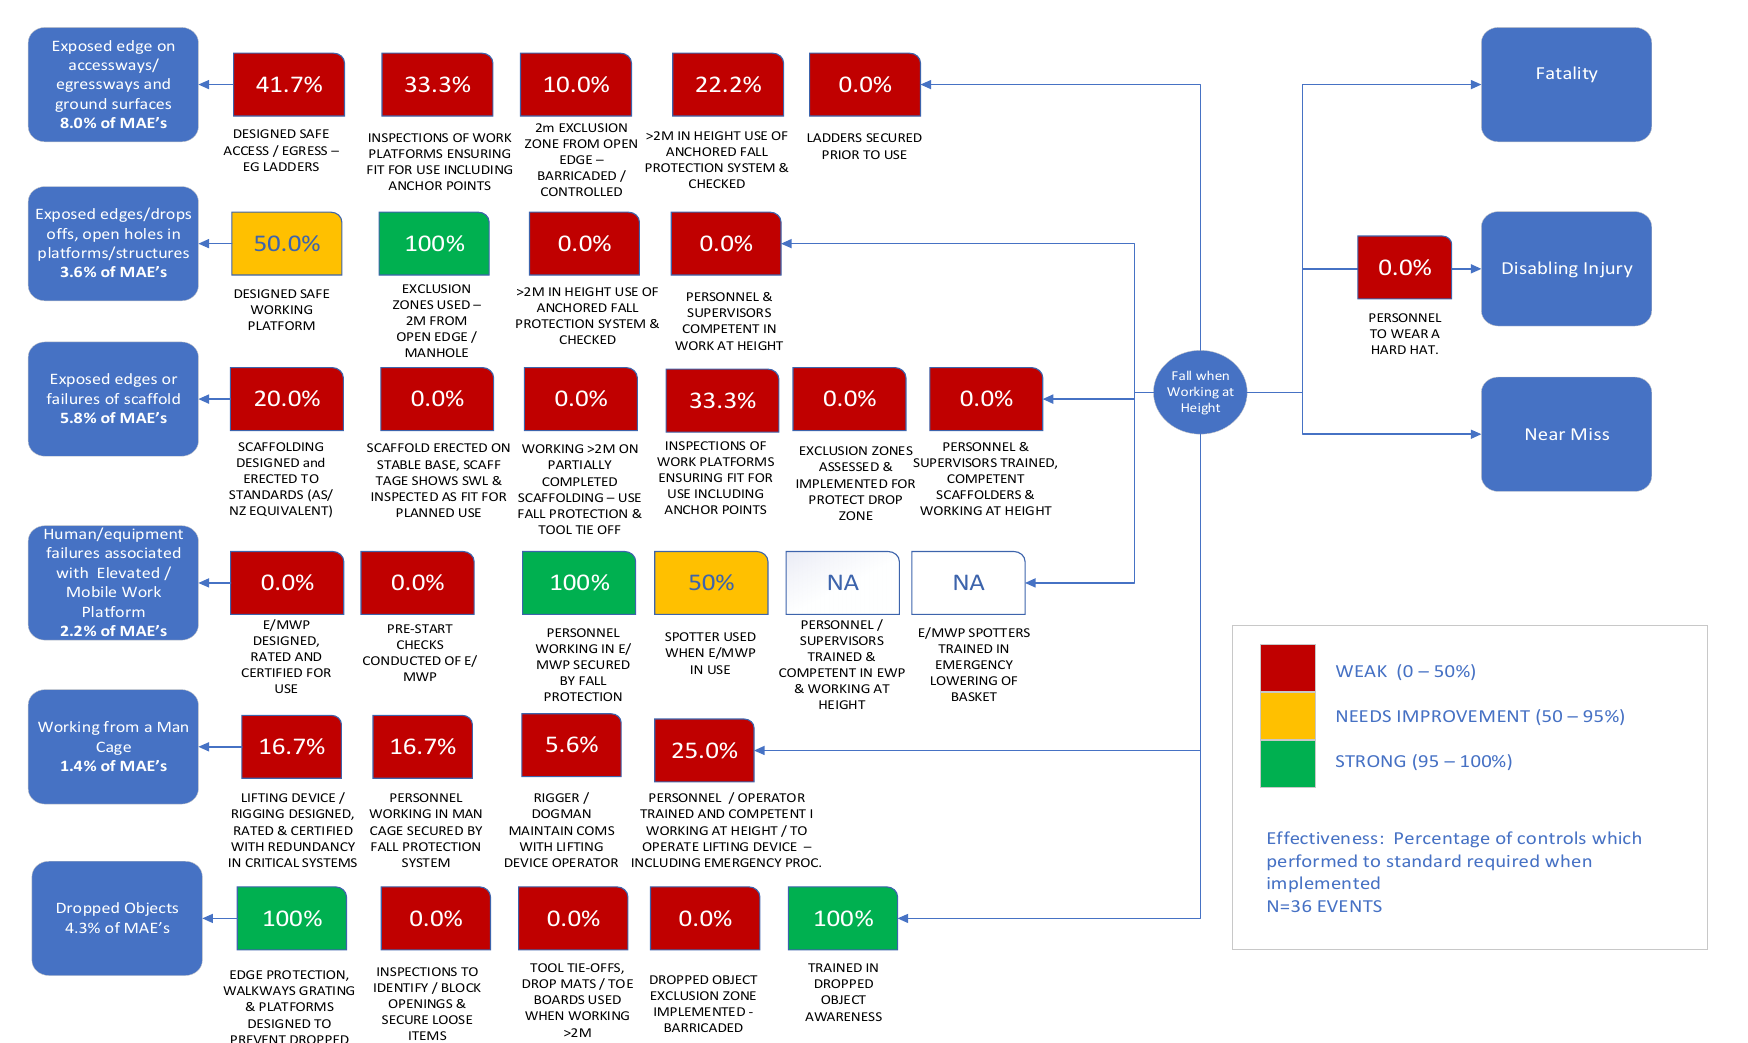
Figure 11. Working at Height—Critical Control Reliability.